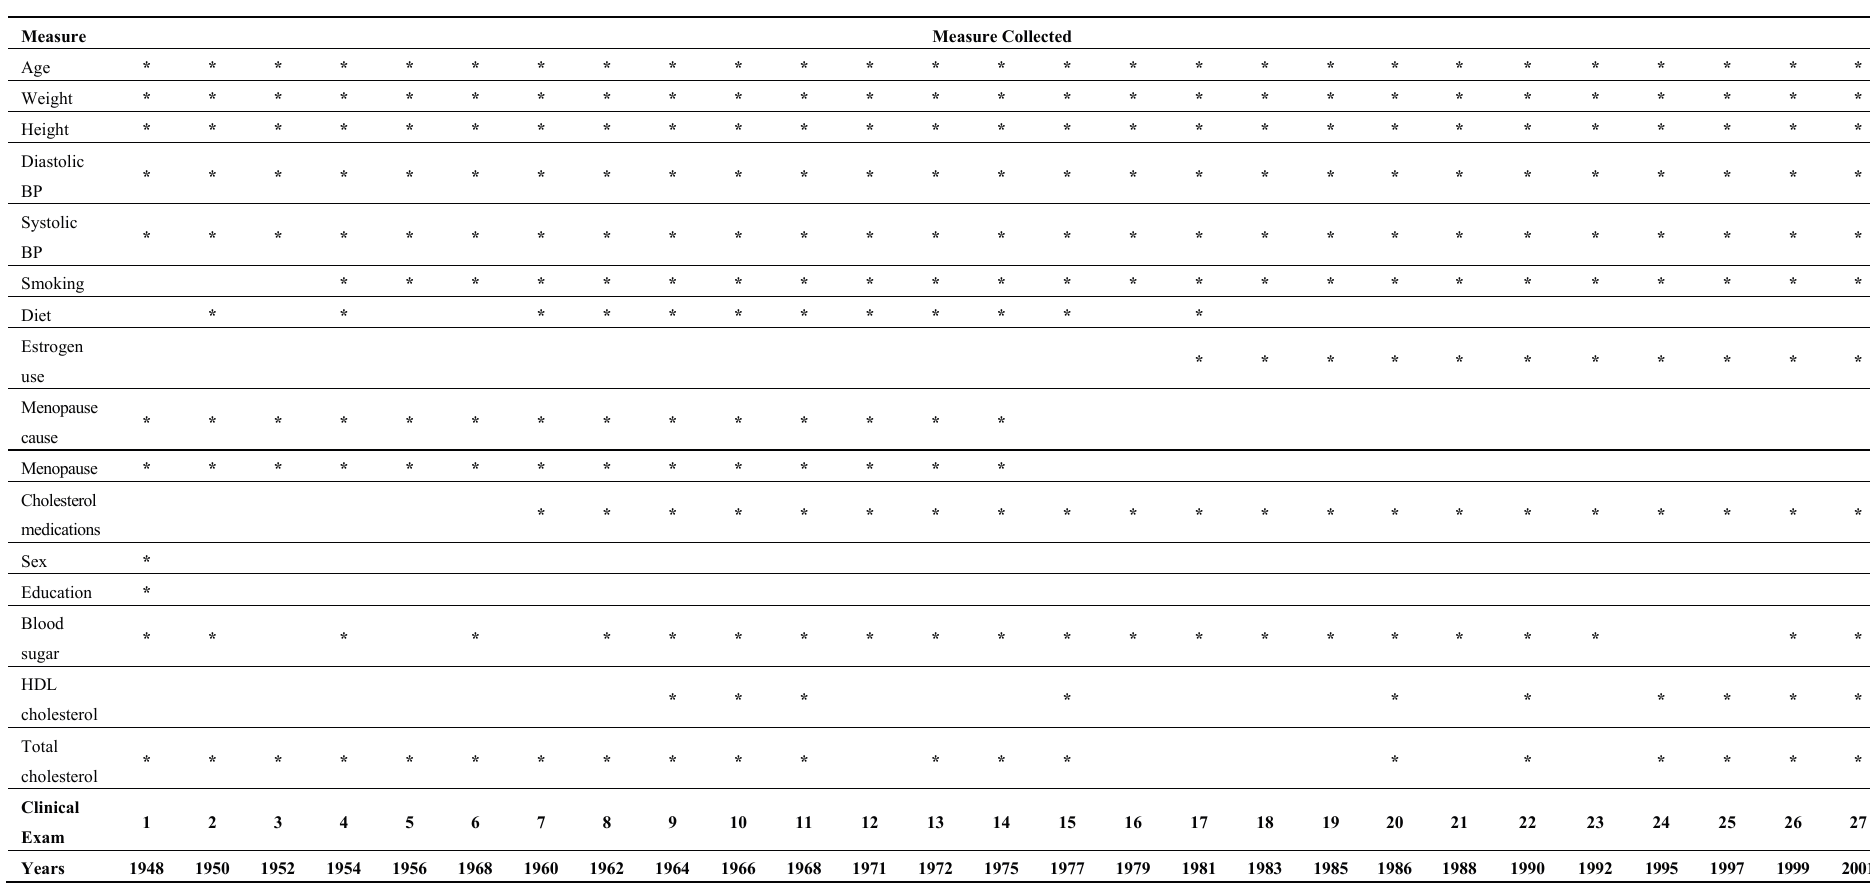
Table 1. Assessment of total cholesterol, HDL cholesterol, and selected covariates from the Framingham Heart Study Original Cohort.